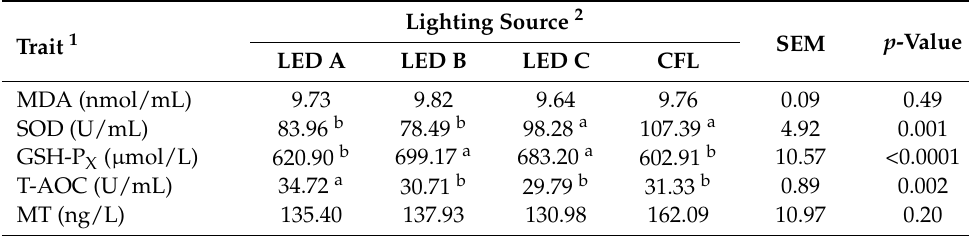
Table 4. Effect of lighting sources on of serum antioxidant status and lipid peroxidation of Beijing-You chickens at 17 week of